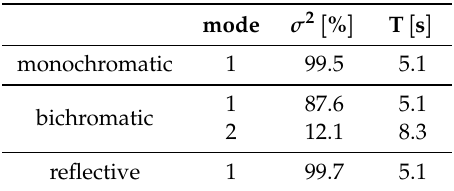
Table 2. Summary of the results of the Principal Component Analysis (PCA) obtained for the 1D